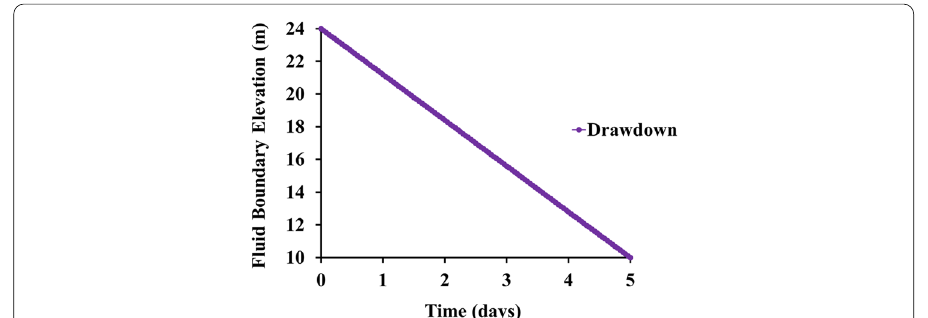
Fig. 18 Reservoir drawdown (DD) condition and rate adopted in the present analysis where reservoir drawdown is conducted after attaining a steady-state phreatic surface in the earthen dam